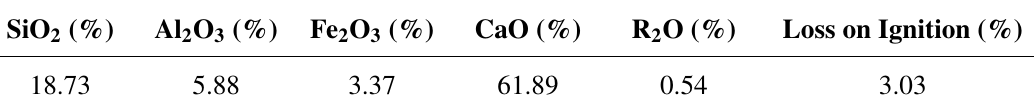
Table 3. Chemical composition (by mass) of cement.